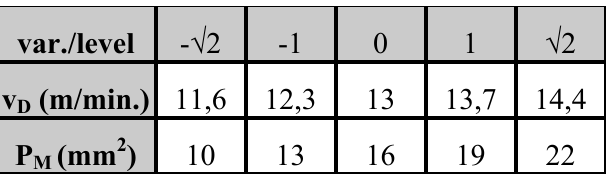
Fig. 17. Central composite 2 variables design Table 1. Setting range of variables